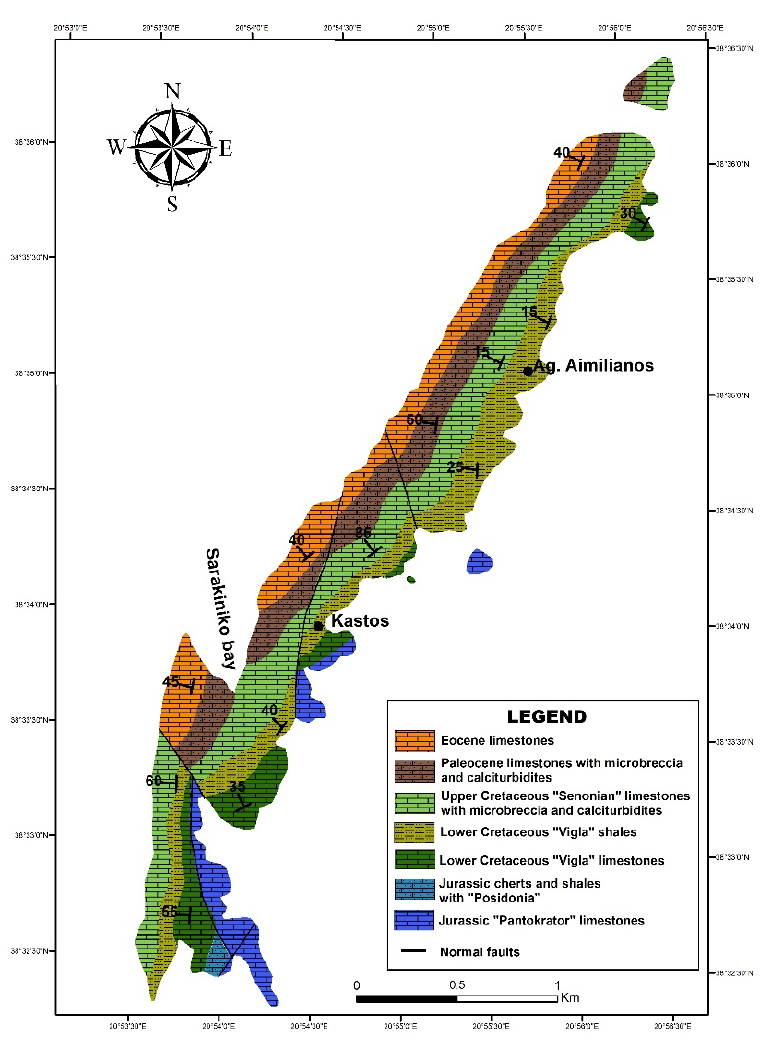
Figure 3. Digitized geological map of Kastos Island [16] based on an original pre-existing geological map [27].